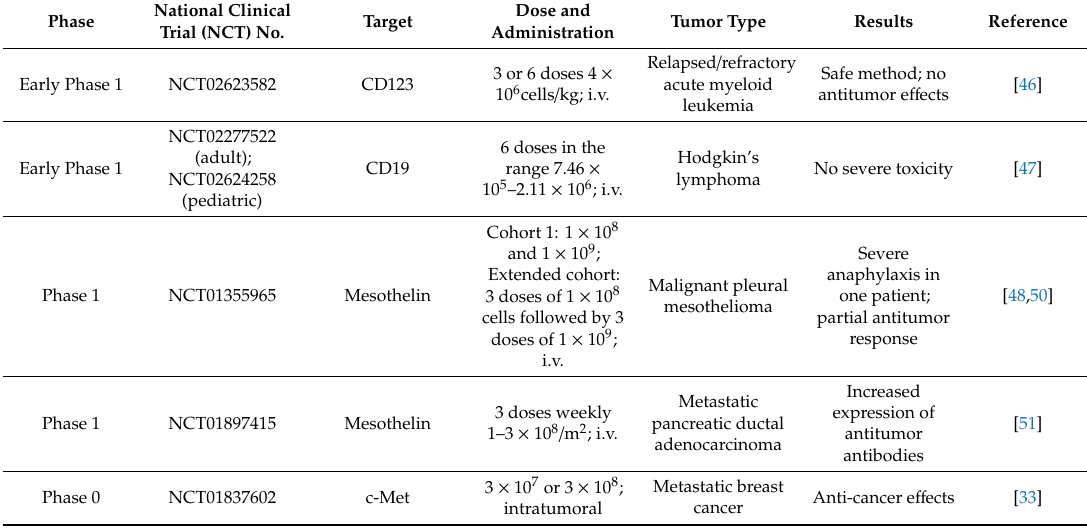
Table 3. Clinical trials regarding the e ff ects of IVT mRNA CAR T cells in hematologic and solid malignancies (i.v.,